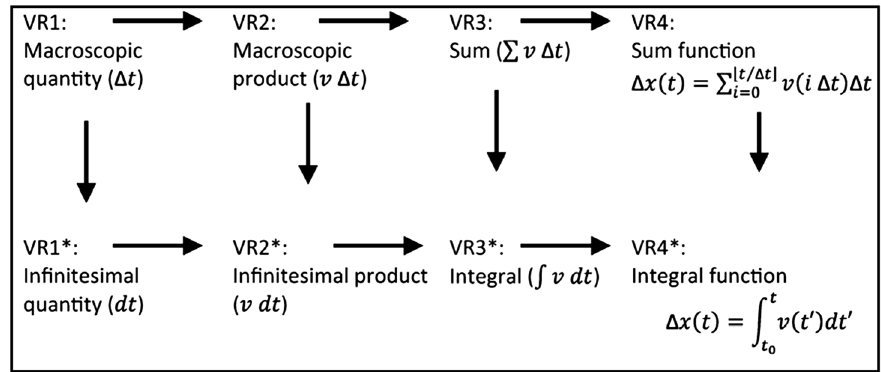
FIG. 1. A network of process-object routes to understanding